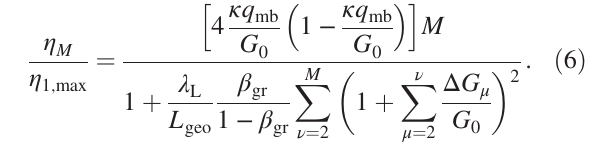
FIG. 3. (a) Efficiency normalized to the single bunch maximum efficiency ð η 1 ; (bottom X-axis) or the structure ’ s geometric length (top X-axis). Each curve represents a different number of bunches in the train: single bunch M ¼ 1 (dotted green), M ¼ 2 (red), M ¼ 10 (dashed blue), and M ¼ 100 (cyan). (b) Contours of efficiency η number of bunches in the train and the corresponding loaded gradient. Other simulations parameters are summarized in Table